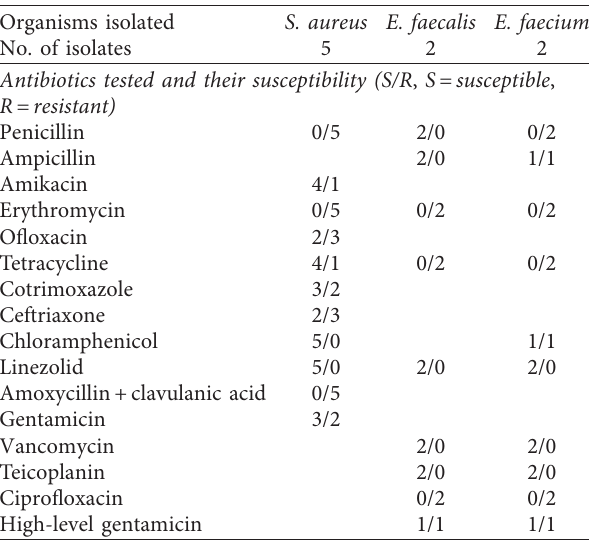
Table 4: Blood culture and antimicrobial susceptibility pattern of 17 IE